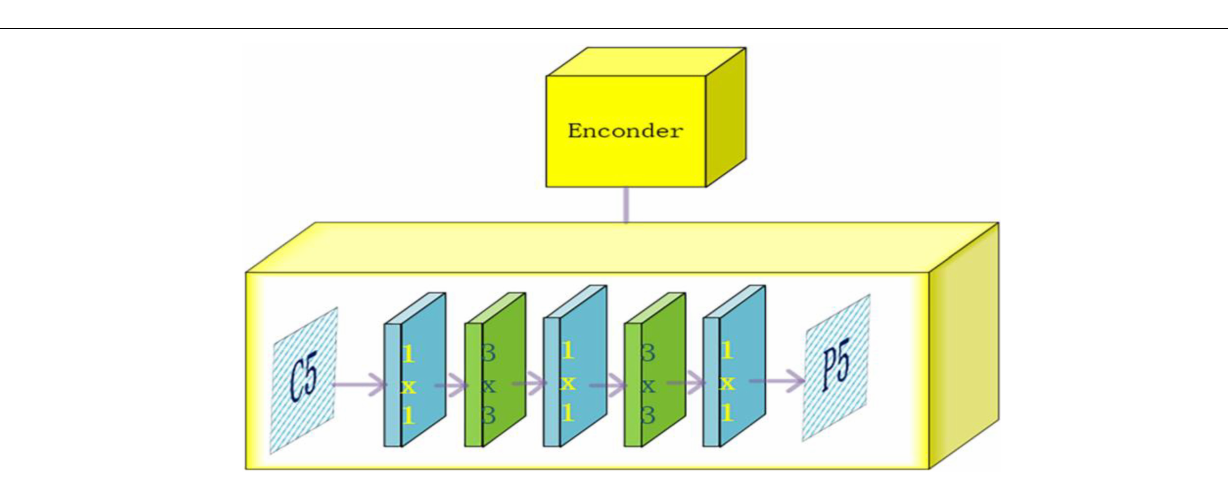
FIGURE 4 | Encoder structure